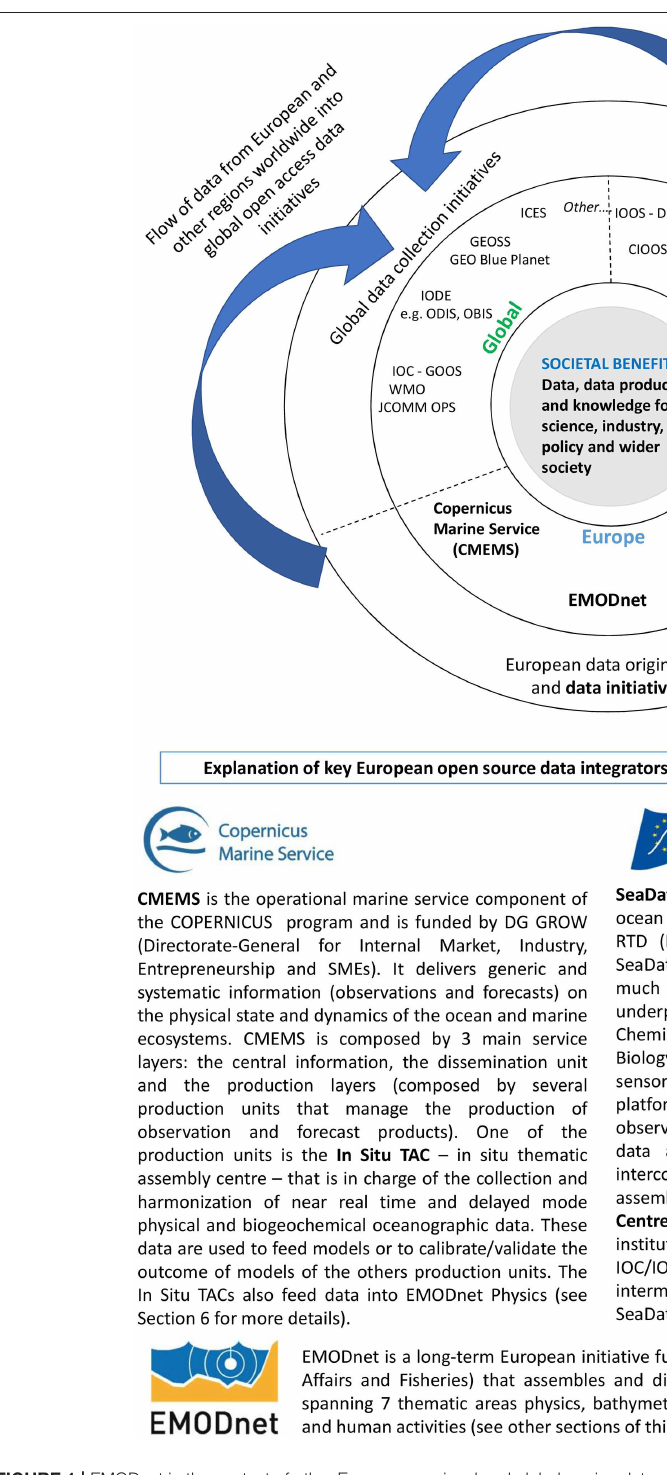
FIGURE 1 | EMODnet in the context of other European, regional and global marine data, and data product initiatives. For Europe, only three pan-European initiatives supported long-term by the European Union are included. This list is not comprehensive but provides some key examples. The Figure shows the flow of marine knowledge from original data (outer circle) to data services (middle circle) and to the users and societal benefits (center). The Figure does not aim to define the wide variety of data collectors and data providers which span academia and public authorities to industry. Data collection networks, systems, and initiatives are also nation and